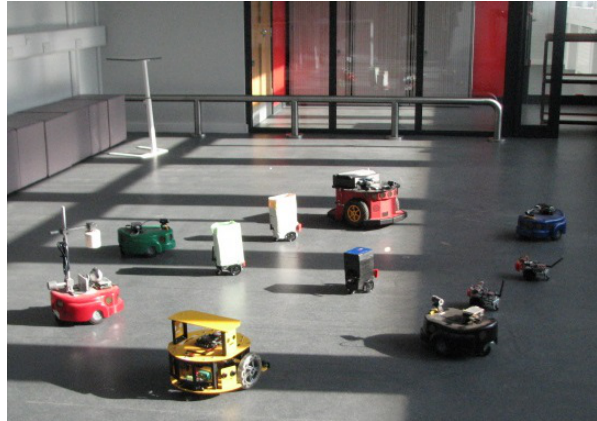
Figure 4: Part of the full complement of the robots used in the developments described